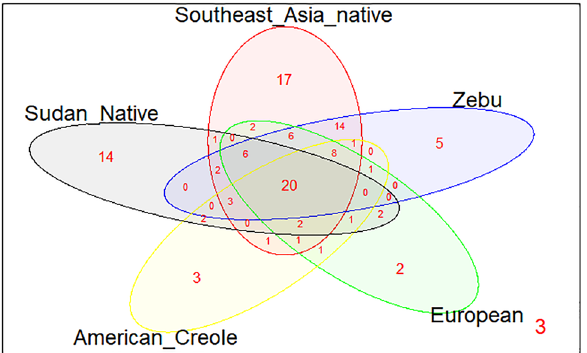
Figure 2. Venn plot of BoLA-DRB3 alleles shared by Sudan native (Baggara, Kenana, and Butana); Southeast Asia (Myanmar and Philippine native breeds); indicine (Nellore, Gir, Brahman, and crossbreeds); European (Hereford, Black and Red Angus, Jersey, Shorthorn, Holstein, overo negro, overo colorado, and crossbreeds); and American Creole (Yacumeño and Hartón del Valle) cattle